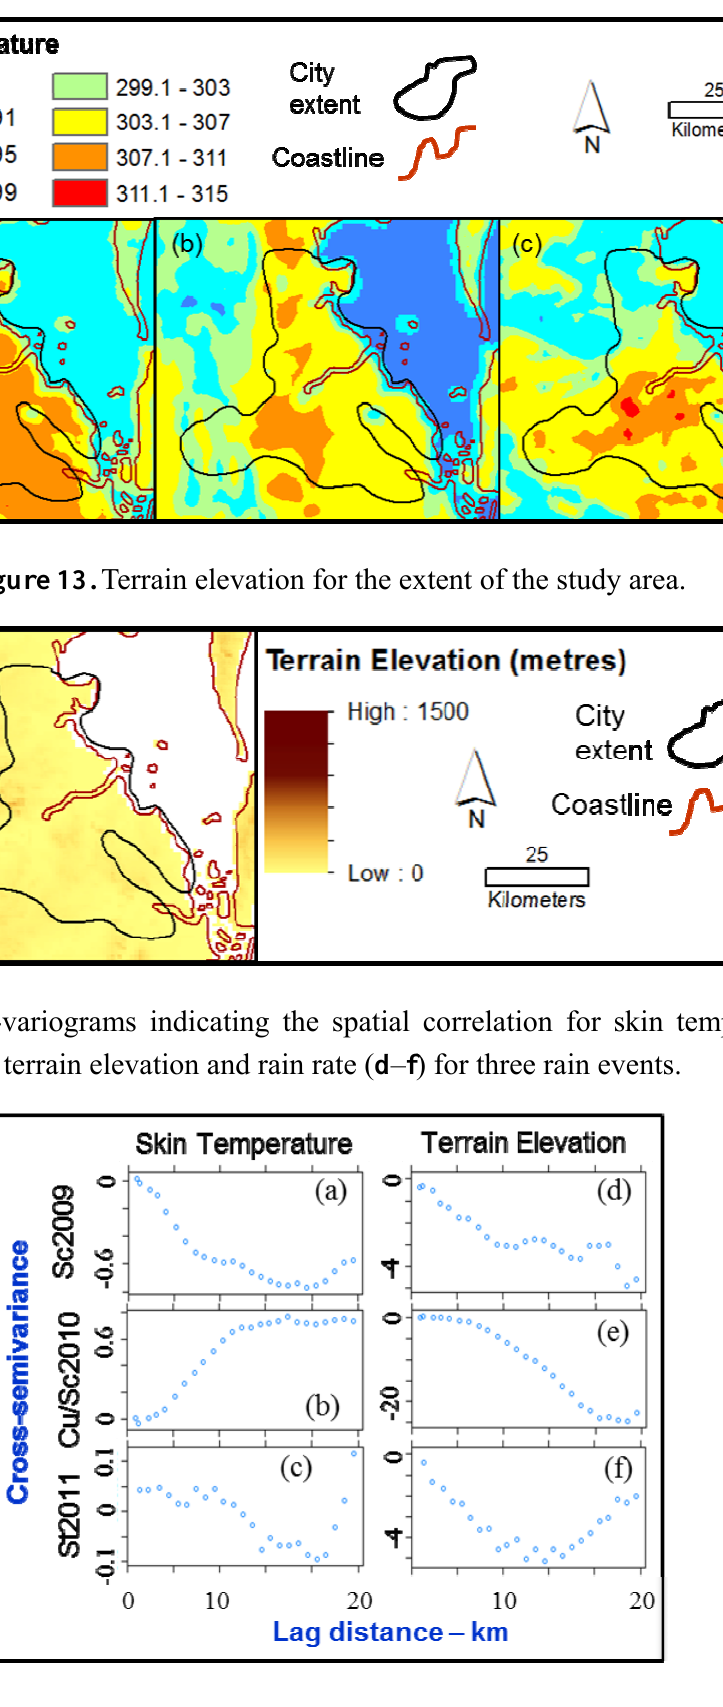
Figure 12. Earth Surface (skin) Temperature at the time of rain rate observation for three rain events ( a ) Sc2009, ( b ) Cu/Sc2010, and ( c ) St2011.